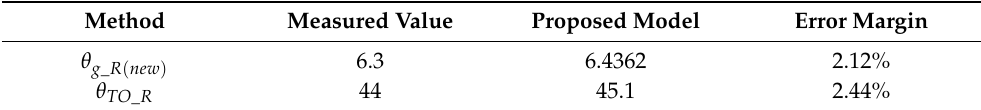
Table 10. Case study 3: 5000 kVA 33/0.42 kV distribution